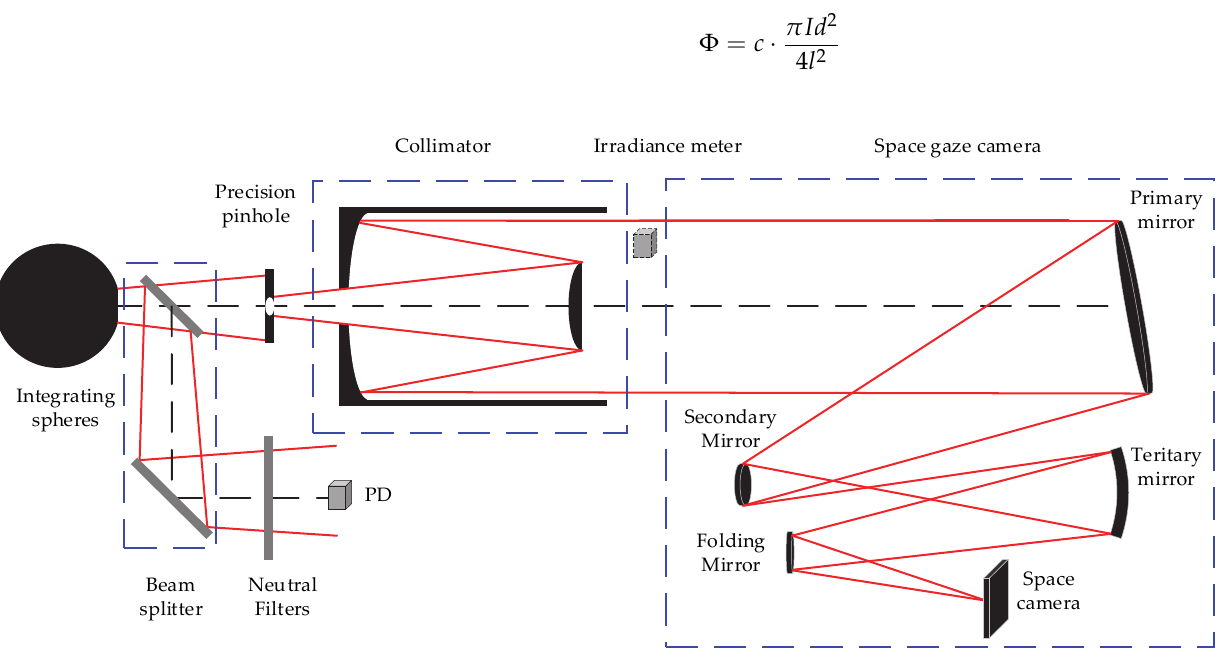
Figure 1. Schematic diagram of the flux calibration device for a large ‐ aperture space telescope.